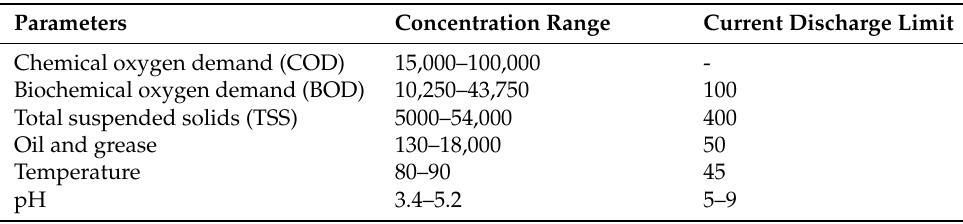
Table 1. General characteristics of raw